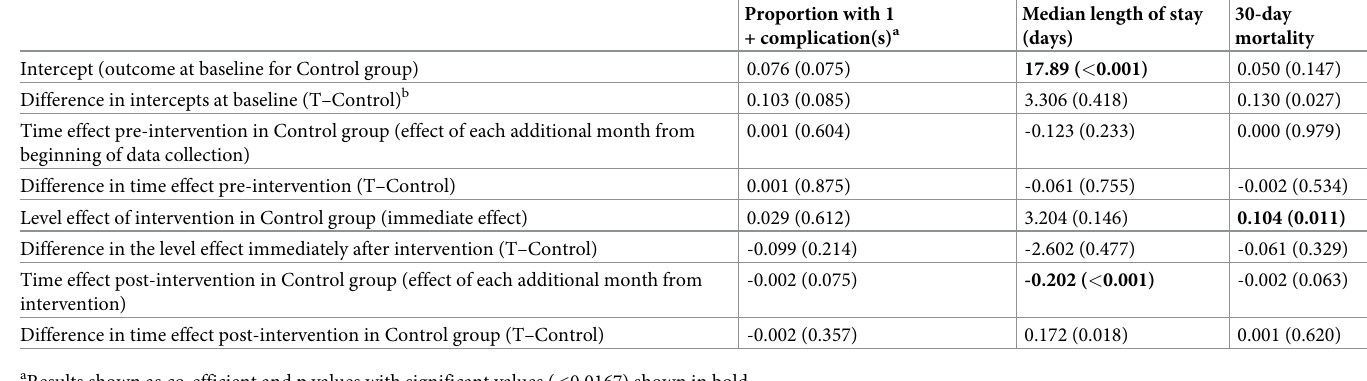
Table 2. ITS comparison of trends in patient outcomes over time and between